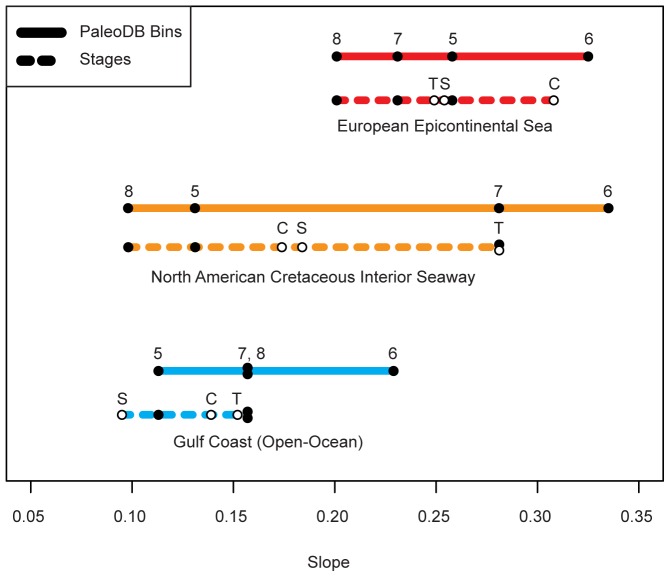
Range of least-squares linear regression slopes for each region.Black dots represent actual slope values, while the colored lines represent the range in values for a given region. Solid lines represent values for analyses using PaleoDB temporal bins (Cretaceous 5–8); dotted lines represent slope values using stage divisions. White dots represent the stages within the Cretaceous 6 PaleoDB time bin: Turonian (T), Coniacian (C) and Santonian (S).